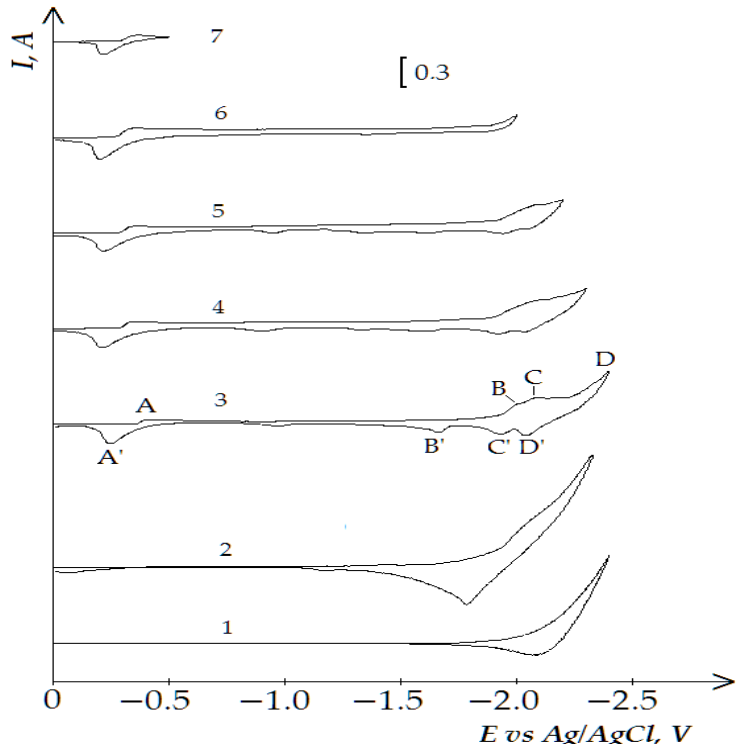
Figure 11. Cyclic voltammograms of electrolytic coreduction of neodymium and cobalt ions on the tungsten electrode in the equimolar KCl-NaCl melt at 973 K, polarization rate of 0.2 V/s, and different reverse potentials: curve (1 and 2)—( − 2.3 V), curve 3 ( − 2.4 V), curve 4 ( − 2.3 V), curve 5 ( − 2.2 V), curve 6 ( − 2.0 V), curve 7 ( − 0.5 V). Concentrations of NdCl 3 : curve 1—0 mol/cm 3 , curves (2–7)—3.0 × 10 − 4 mol/cm 3 . Concentrations of CoCl 2 : curves (1 and 2)—0 mol/cm 3 , curves (3–7)—5.0 × 10 − 5 mol/cm 3 . A square of the cathode is 0.4 cm 2 .